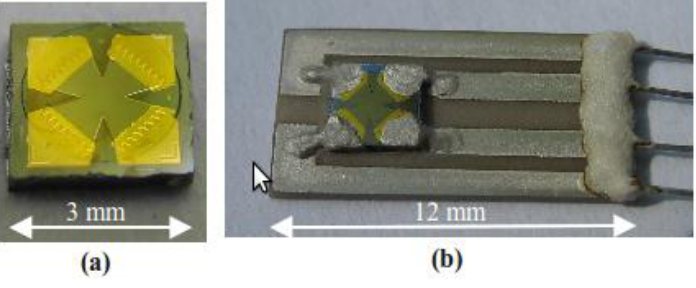
Figure 1. Extreme-temperature Hall sensor; (a) ETHS structure. Maltese